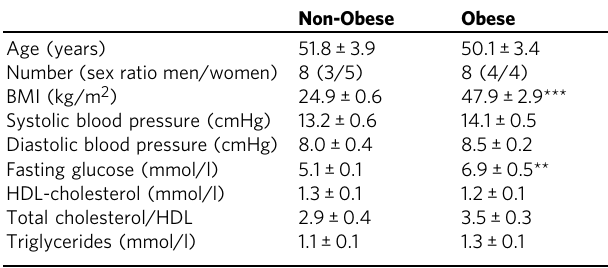
Table 1 Clinical and laboratory characteristics of non-obese and obese